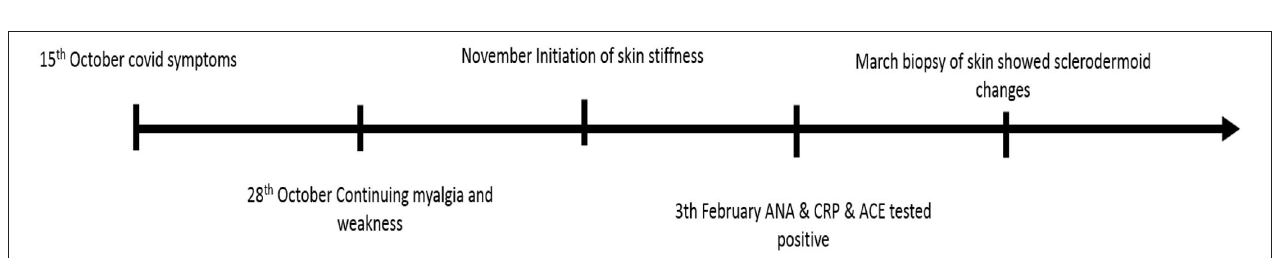
FIGURE 2 | Thickening and hyalinization of connective tissue of deep dermis, subcutaneous fat and muscular fascia, and mucin deposition (A) . Atrophy of adnexal structures, increased fibroblastsand dense collagens through the deep dermis (B) . Infiltrative changes in the eccrine glands (C) . No obvious eosinophilic infiltration was detected.